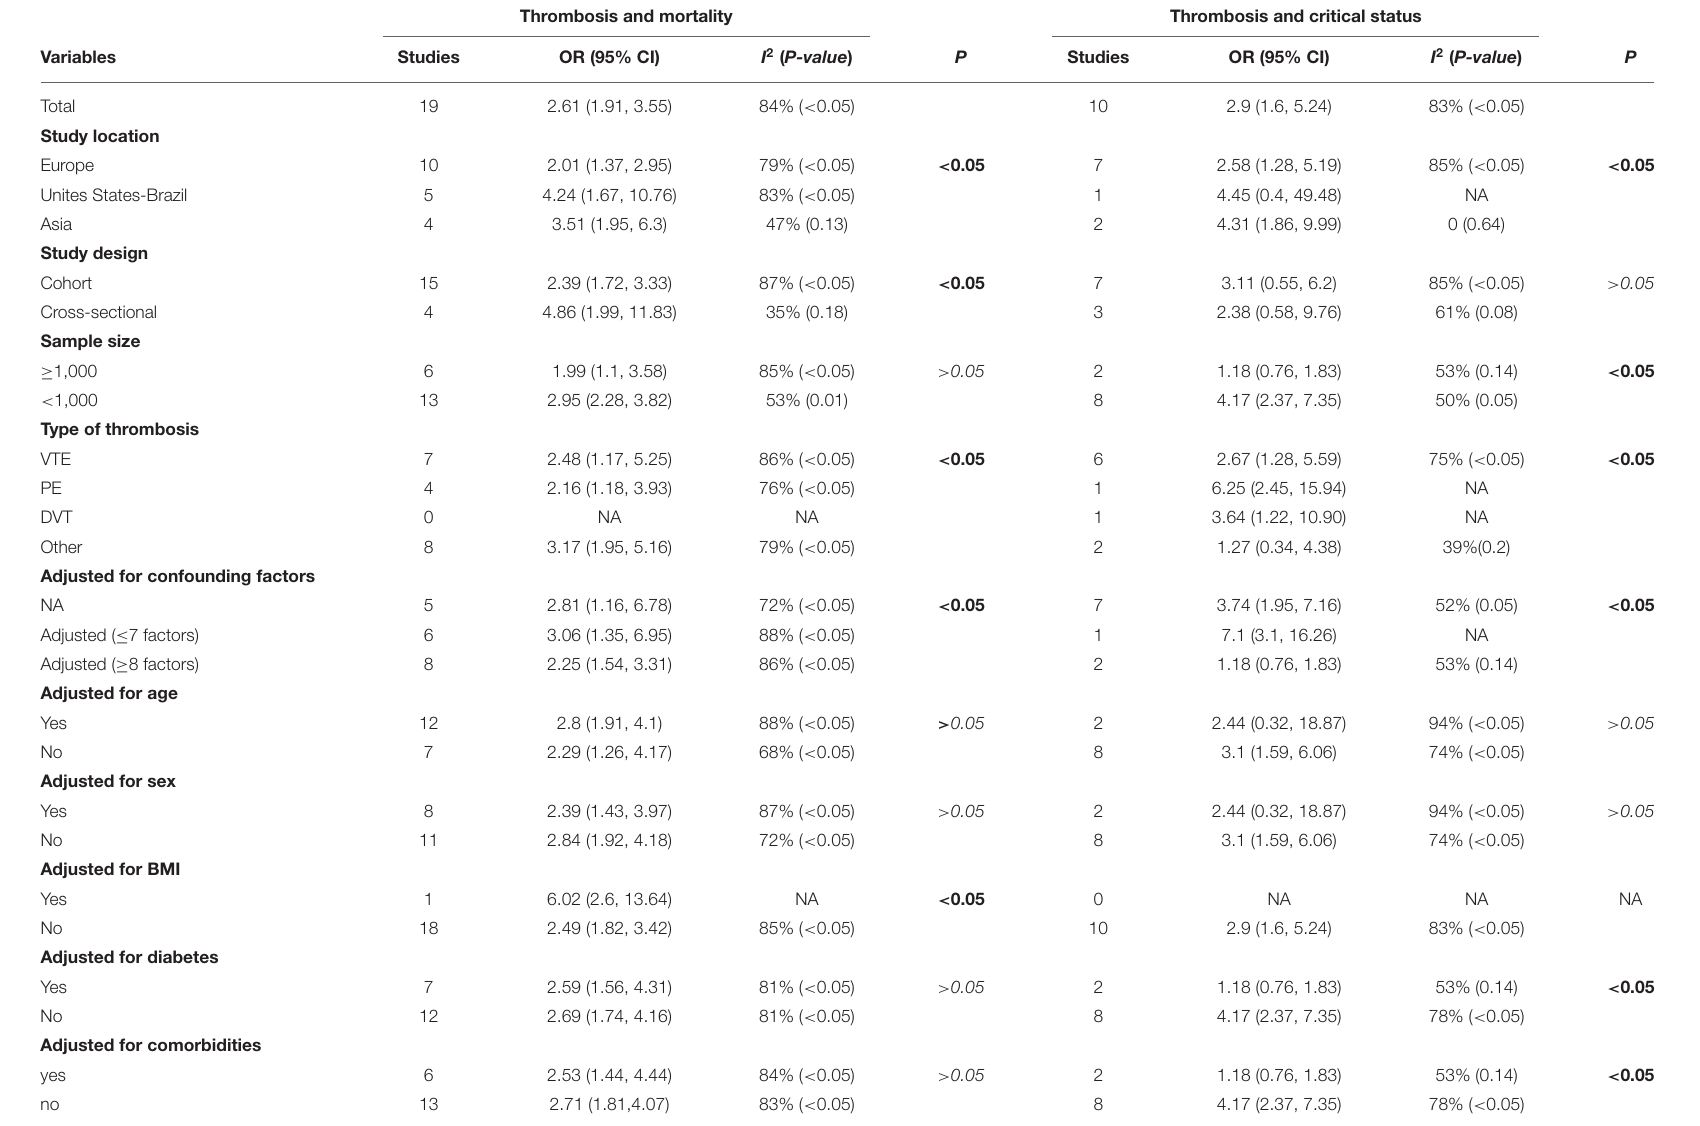
TABLE 2 | Stratified analysis of the associations between thrombosis and mortality and COVID-19-related critical status. Thrombosis and